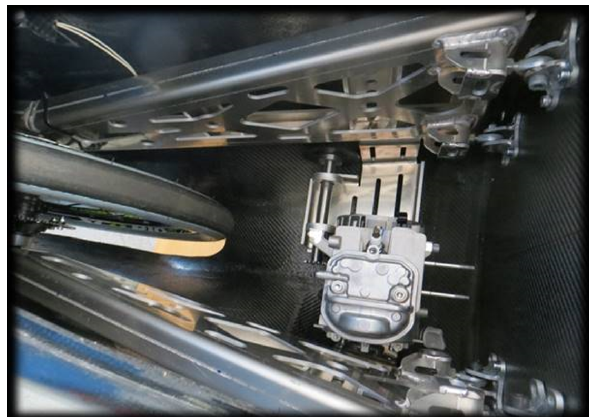
Figure 8: 3D model of rear axle with engine and gears.